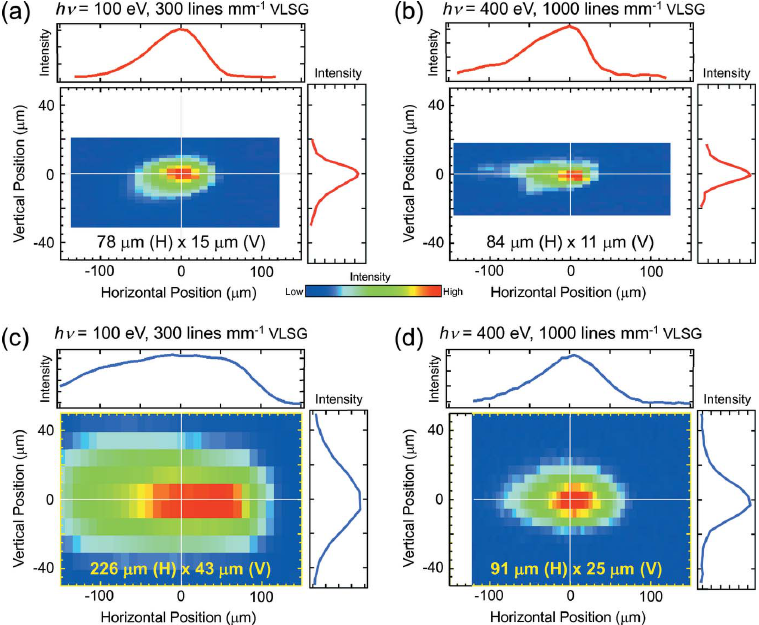
Figure 4 Comparison of experimentally determined profiles of the horizontal linear polarized beam ( a , b ) after and ( c , d ) before upgrading the M3 mirror. The photon energies were 100 eV ( a , c ) and 400 eV ( b , d ) using the 300 and 1000 lines mm (cid:2) 1 VLSGs, respectively. The exit-slit width was 30 m m for all measurements. The beam profiles are the images seen from the upstream side. Integrated intensities along the vertical and horizontal axes are shown on the upper and right sides of each panel,